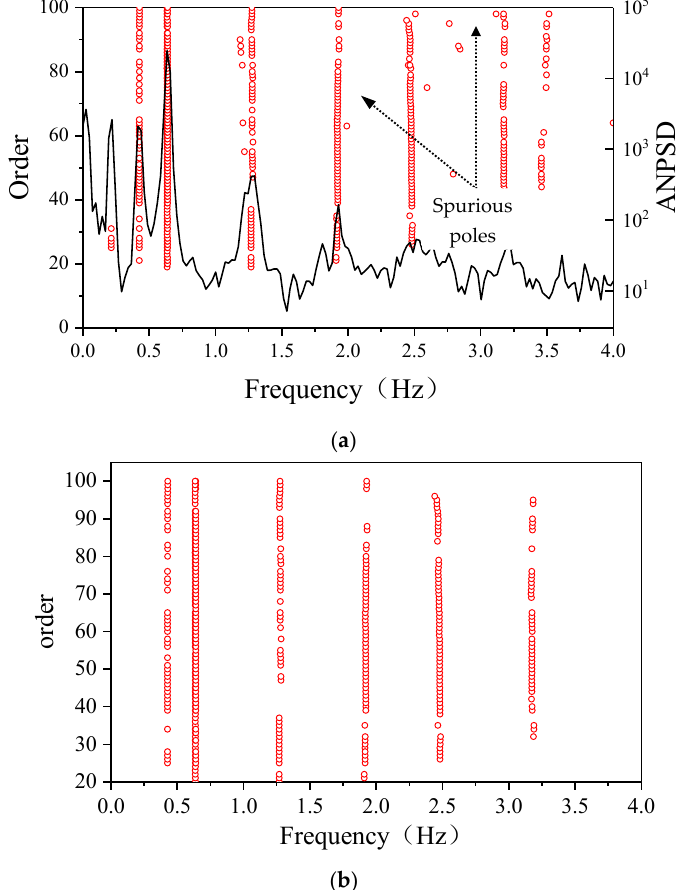
Figure 2. Original and cleaning stabilization diagrams. ( a ) Original stabilization diagram; ( b ) cleaning stabilization diagram.